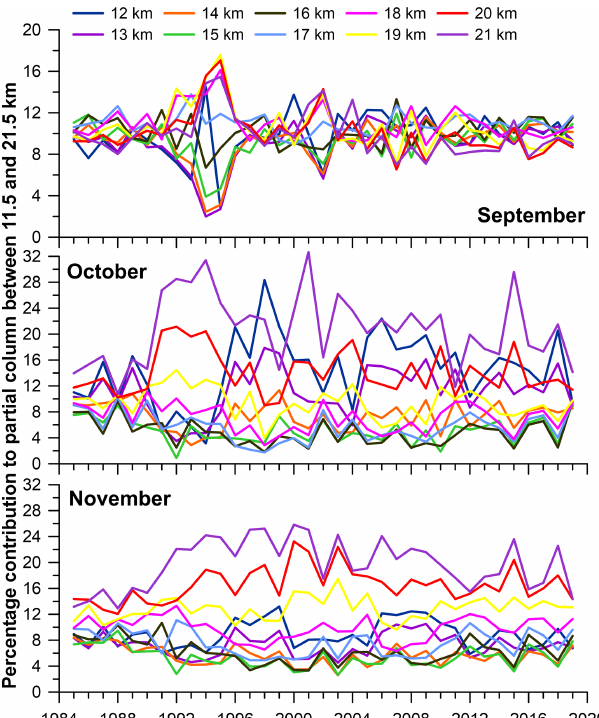
Figure 10. Percentage contribution of each 1km thick layer to the monthly mean, polar cap mean (75 ◦ to 90 ◦ S equivalent latitude), partial ozone column between 11.5 and 21.5km for September, Oc- tober, and November (Southern Hemisphere spring) of each year from 1985 to